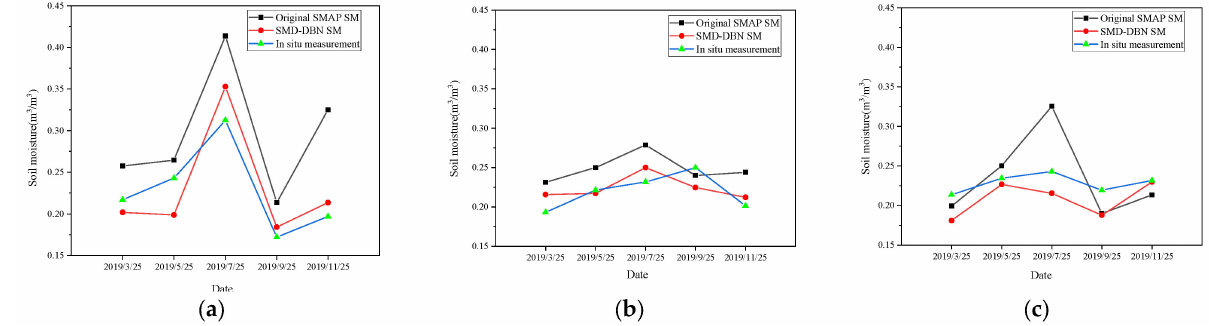
Figure 8. Time series SM data of station L6 ( a ), M5 ( b ), and S2 ( c ).